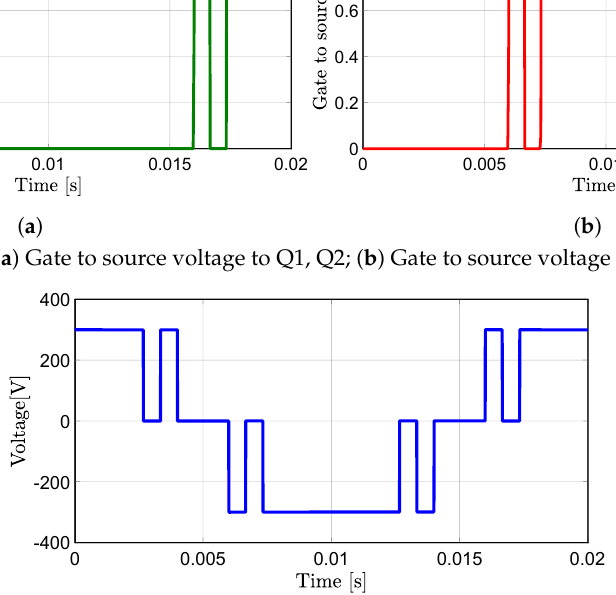
Figure 5. The generated voltage to the single-phase asynchronous